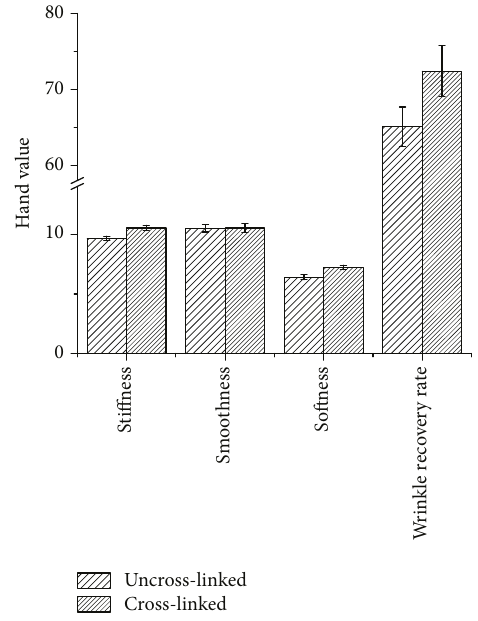
Figure 6: Fabric hand values of NCS before and after cross-linking.